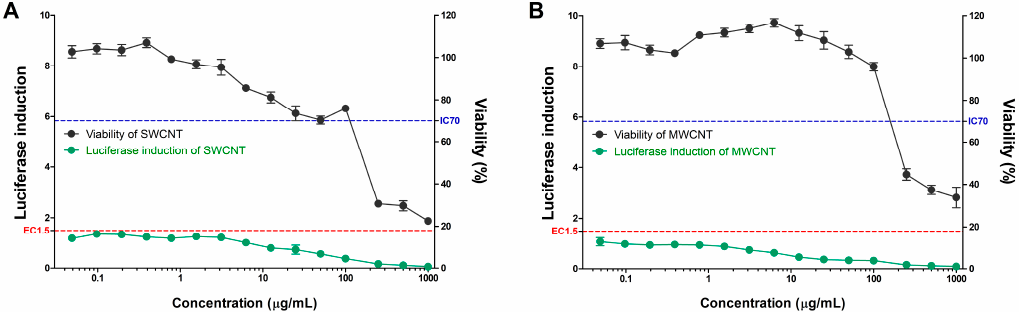
Figure 2. The induction of luciferase activity (green line) and cell viability (black line) in the KeratinoSens TM assay. KeratinoSens TM cells were treated with the ( A ) SWCNTs and ( B ) MWCNTs. Data are expressed as mean ± standard deviation values ( n = 6).